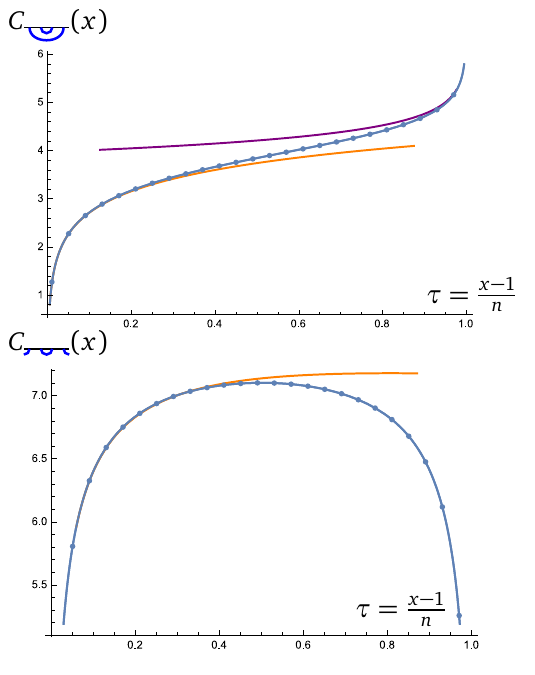
Figure 2: The correlation functions C ( x ) and C ( x ) for ϕ = 1. The points are the exact values for n = 200. In the left panel, the blue, orange and purple solid curves are drawn from (4.23), (4.26a) and (4.26b). In the right panel, the blue and orange curves are drawn from (4.28) and